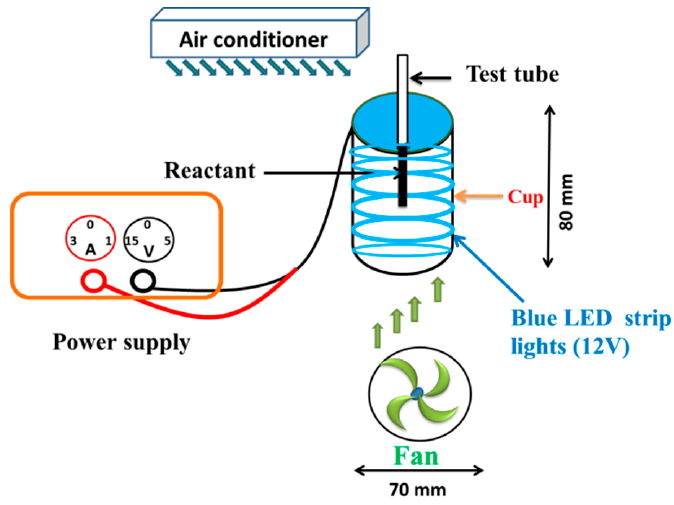
Figure 11. Experimental setup of the photolytic equipment.